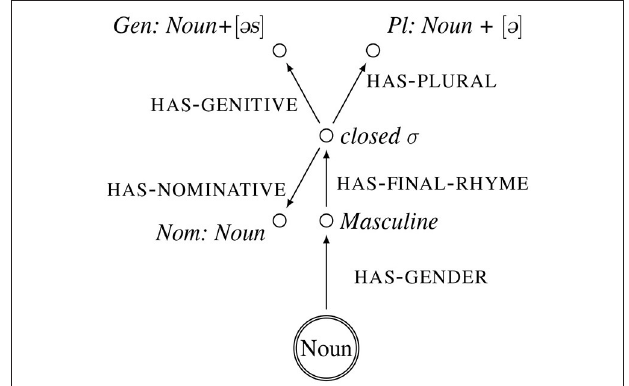
FIGURE 1 | Frame representation of the inflectional class of nouns such as [ tak ] “day.” Noun + [ @s ] indicates that the value of this attributes is [ tag@s ].